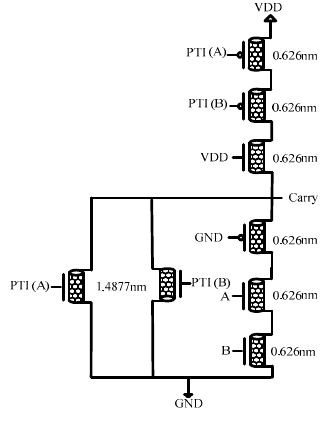
Figure 3. Schematic design of the proposed exact carry output digit.